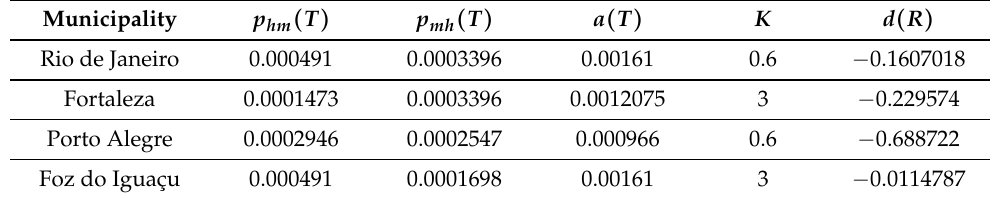
Table 4. Adapted parameter values resulting from the exploratory analysis in four different geo- graphical contexts. Concerning the temperature and rainfall dependent functions, the new value substitutes the a variable within their